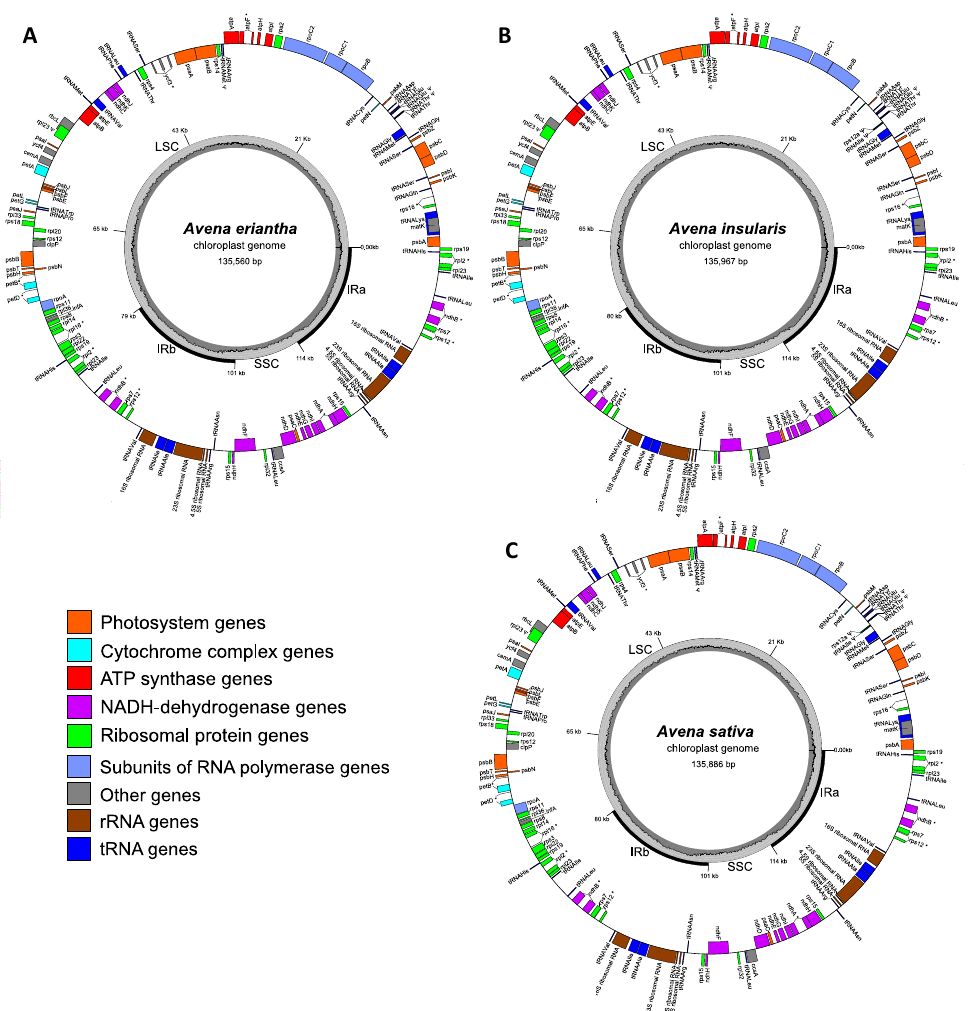
Figure 1. Gene maps of three selected Avena chloroplast genomes: ( A ) A. eriantha (2x), ( B ) A. insularis (4x), and ( C ) A. sativa (6x). Each map is represented in, moving counterclockwise from the right. The larger circle represents the layout of chloroplast genes distribution as per their transcription direction: outside boxes and inside boxes show the counterclockwise and clockwise transcription. The color of the gene box indicates the functional group that the gene belongs to. The smaller circle represents the CG content plot in the corresponding sample. LSC, large single copy region; SSC, small single copy region. IRa / b, inverted repeats. Intron-containing genes are marked by a ‘ ∗ ’ symbol and pseudogenes are marked by a ‘ Ψ ’ symbol.